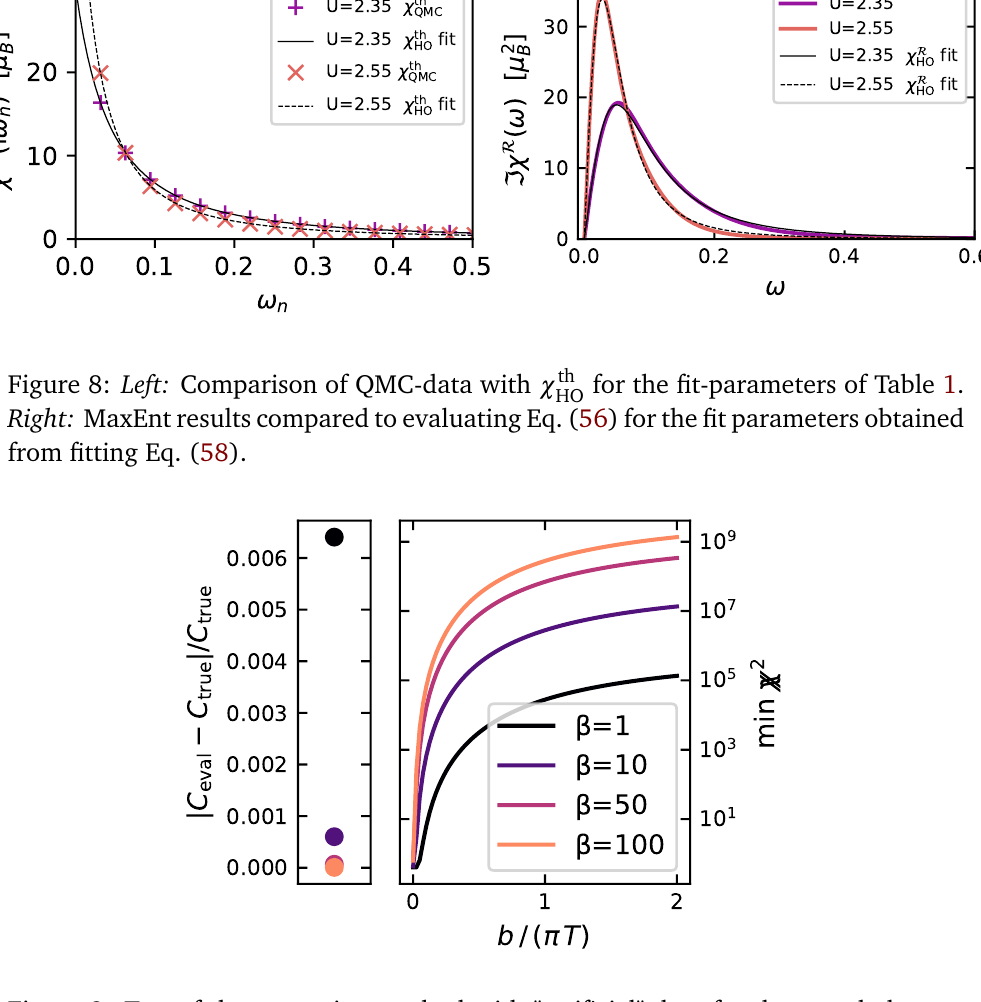
Figure 9: Test of the extraction method with "artificial" data for the exactly known atomic limit case. Relative error in the predicted C (left); Minimal value fit loss χχ 2 as a function of blur-width b for different temperatures